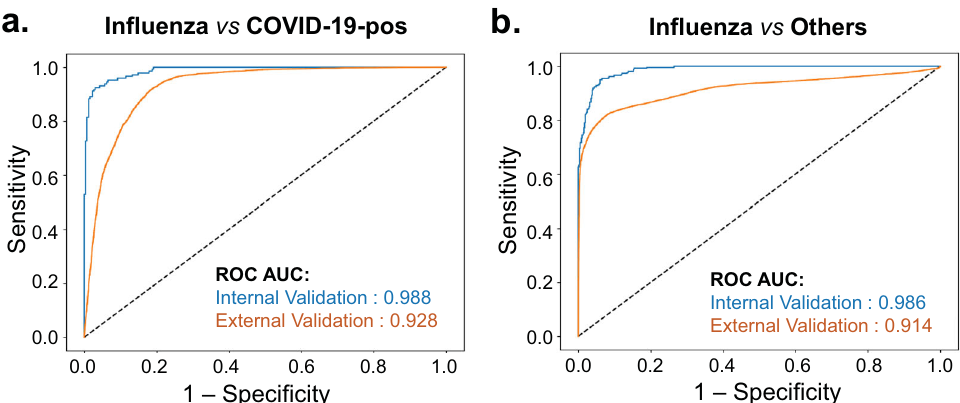
Fig. 1 Receiver operating characteristic (ROC) curves of in fl uenza vs COVID-19-positive and in fl uenza vs other predictive models. Area under the ROC curve showing the predictive performance of the a in fl uenza versus COVID-19-positive model and b in fl uenza versus other prediction models on the internal test and external validation datasets.